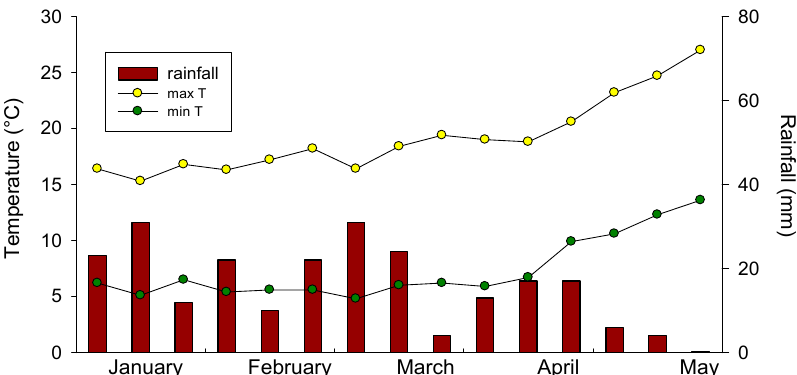
Figure 1. Average ten-day trend of maximum and minimum air temperatures and ten-day total rainfall during the trial.